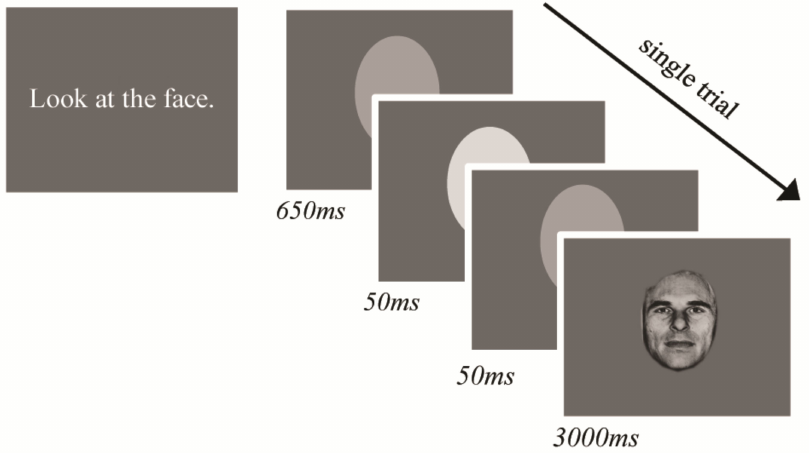
Figure 1. Eye-tracking paradigm trial structure and stimulus